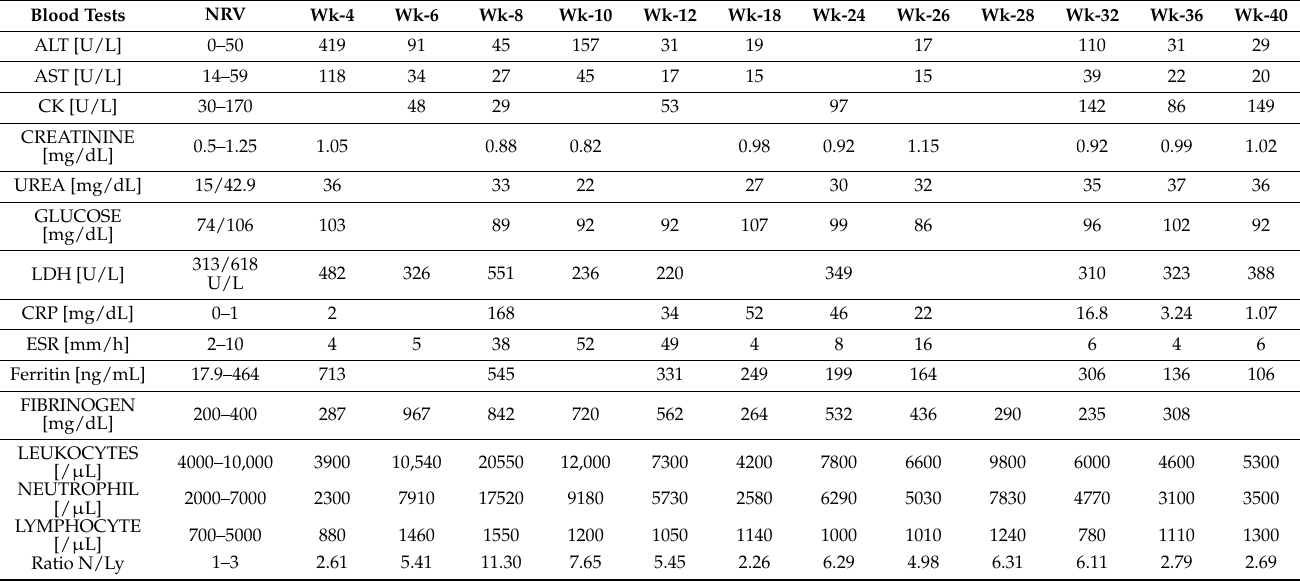
Table A2. Post-Covid-19 biological progress of results associated with spondylodiscitis diagnostic and conservative